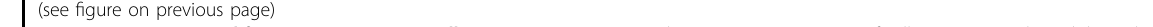
Fig. 6 mTOR is required for MDM4 activity on cell migration. a Upper panel: representative pictures of cell migration evaluated through wound- healing assay of Empty Vector- or SK-OV-3 cells expressing wt or MDM4 deletion mutants + GFP as indicated. Pictures were taken at time 0 and 24 h after the scratch. Scale bar = 200 M μ b quanti fi cation of cell migration ( n = 4, one-way ANOVA for multiple comparisons, Empty vector vs wt-MDM4, p = 0.0135; Empty vector vs BD, p = 0.015; Empty vector vs BD + RF, p = 0.04). BD = p53-binding domain, RF = Ring Finger domain, Central = Central domain- lacking both BD and RF domains. c WB of MDM4 deletion mutants used in a . d Representative images of cell migration of Empty Vector and MDM4-SK-OV-3 cells using Rapamycin (Rapa) or vehicle (DMSO). Representative micrographs show the analysis performed with Cell Pro fi ler 3.1.9, 15 h after scratching. Colors are randomly assigned by the software. e Quanti fi cation of cell migration shown in c using Fiji ( n = 4, one-way ANOVA for multiple comparisons, Empty Vector + DMSO vs MDM4 + DMSO, p = 0.004; Empty Vector + DMSO vs Empty vector + Rapa, p = 0.01; Empty Vector + DMSO vs MDM4 + Rapa, p = 0.0002). f Quanti fi cation of cell con fl uency shown in c (one-way ANOVA for multiple comparisons, Empty Vector + DMSO vs MDM4 + DMSO, p = 0.04; Empty Vector + DMSO vs Empty vector + Rapa, p = 0.001; Empty Vector + DMSO vs MDM4 + Rapa, p = 0.0003). g Cell velocity analysis of cell migration shown in c ( n = 392 cells for Empty Vector + DMSO, n = 229 cells for MDM4 + DMSO, n = 170 cells for Empty Vector + Rapa, n = 232 for MDM4 + Rapa, one-way ANOVA for multiple comparisons, Empty Vector + DMSO vs MDM4 + DMSO, p < 0.0001; Empty Vector + DMSO vs Empty vector + Rapa, p <